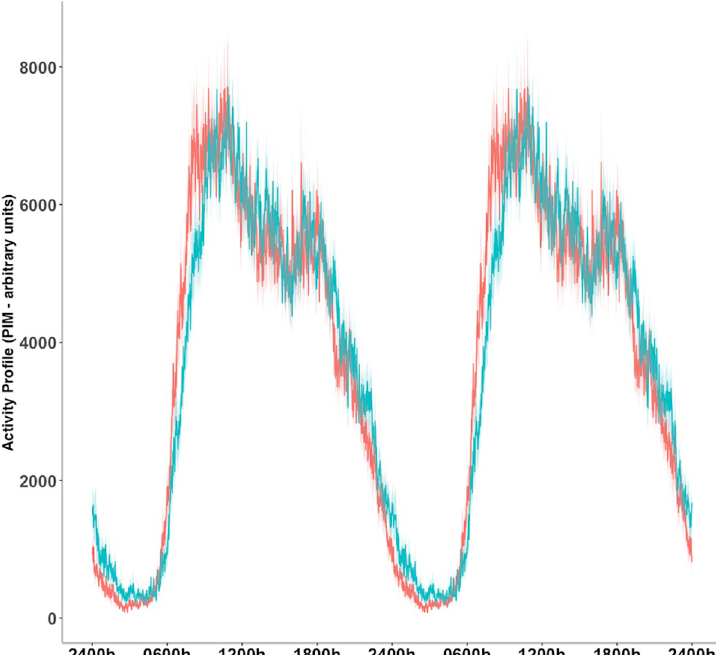
Fig 2. 24-hour profiles of motor activity profiles, separated by groups. Data are represented in a double plot averaged across five days. The means (bold line) and standard error of the means (shadow) are presented for the MetS group (blue) and Non-MetS group